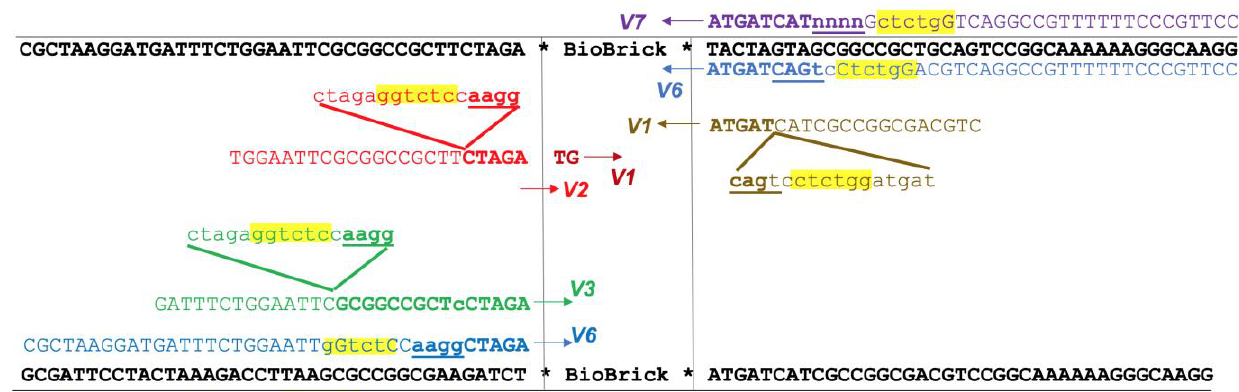
Figure 1. Primer binding GEM-Gate amplification. The prefix and suffix sequences flanking BioBricks are shown in black, from 5′ > 3′ on the top line and 3′ > 5′ on the bottom. Forward and reverse primers are shown antiparallel to their target, with mismatched bases shown as lower case. Regions of the primer which loop out are shown as an inset to the main sequence. The BsaI recognition site is highlighted in yellow for each primer, and the resulting overhang is underlined. The overhang and any downstream sequences are shown in bold. Different versions of the primer are shown — forward V1 binds only coding BioBricks (maroon), while V2 is weaker but binds any BioBrick (red). Stronger binding V3 (green) leaves a larger scar sequence. Instead of looping out the BsaI site, V6 (blue) and V7 (purple) primers include it as mismatches. These differences between primers are mirrored in the reverse primers for V1 (brown), V6 (blue), and V7 (purple).